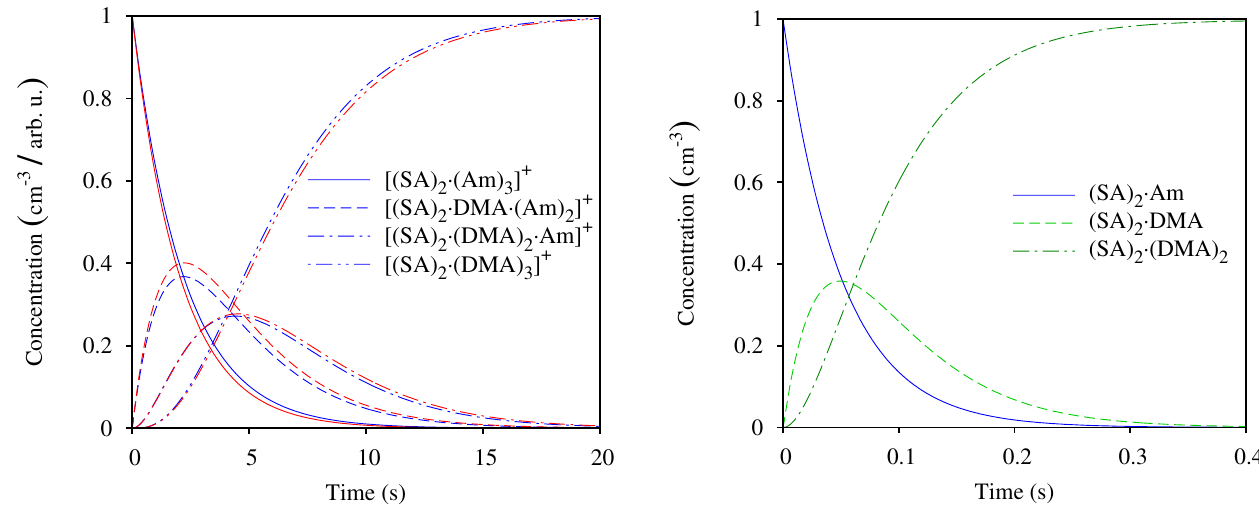
Fig. 3. Reaction of ( SA ) 2 · Am clusters with DMA gas at a pressure of 10 − 6 Torr.